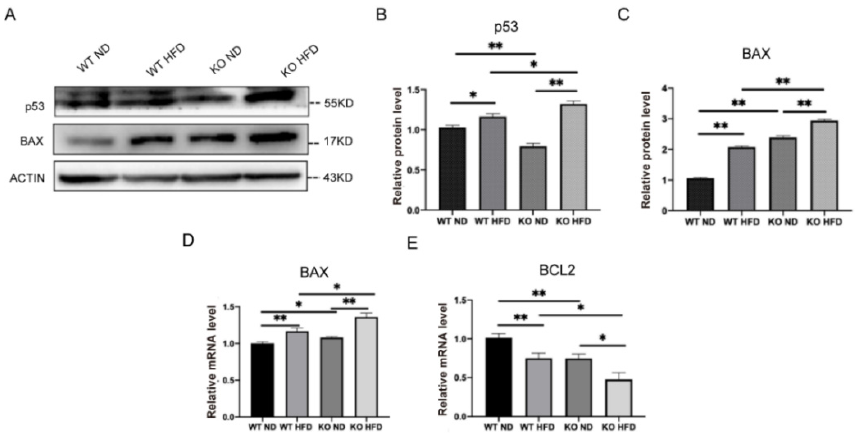
Figure 7. TRIM67 deletion induces apoptosis in hypothalamus. ( A ) The protein levels of BAX and P53 in hypothalamus ( n = 3). ( B , C ) The gray value statistical analysis of BAX and P53, respectively ( n = 3). ( D ) The expression level of BAX in hypothalamus ( n = 4). ( E ) The expression level of BCL2 in hypothalamus ( n = 4). Four samples from each group were used for RT-qPCR analysis and two duplicate samples were measured. The data are presented as means ± SEM. * p -value < 0.05; ** p -value < 0.01.